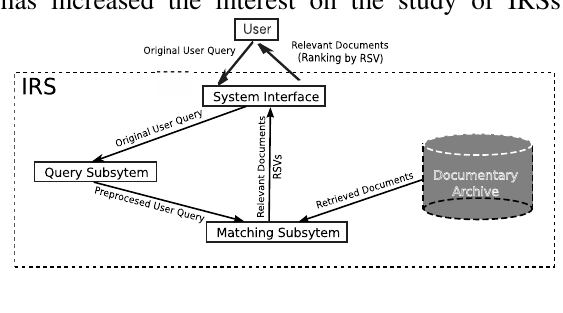
Fig. 1. Components of an